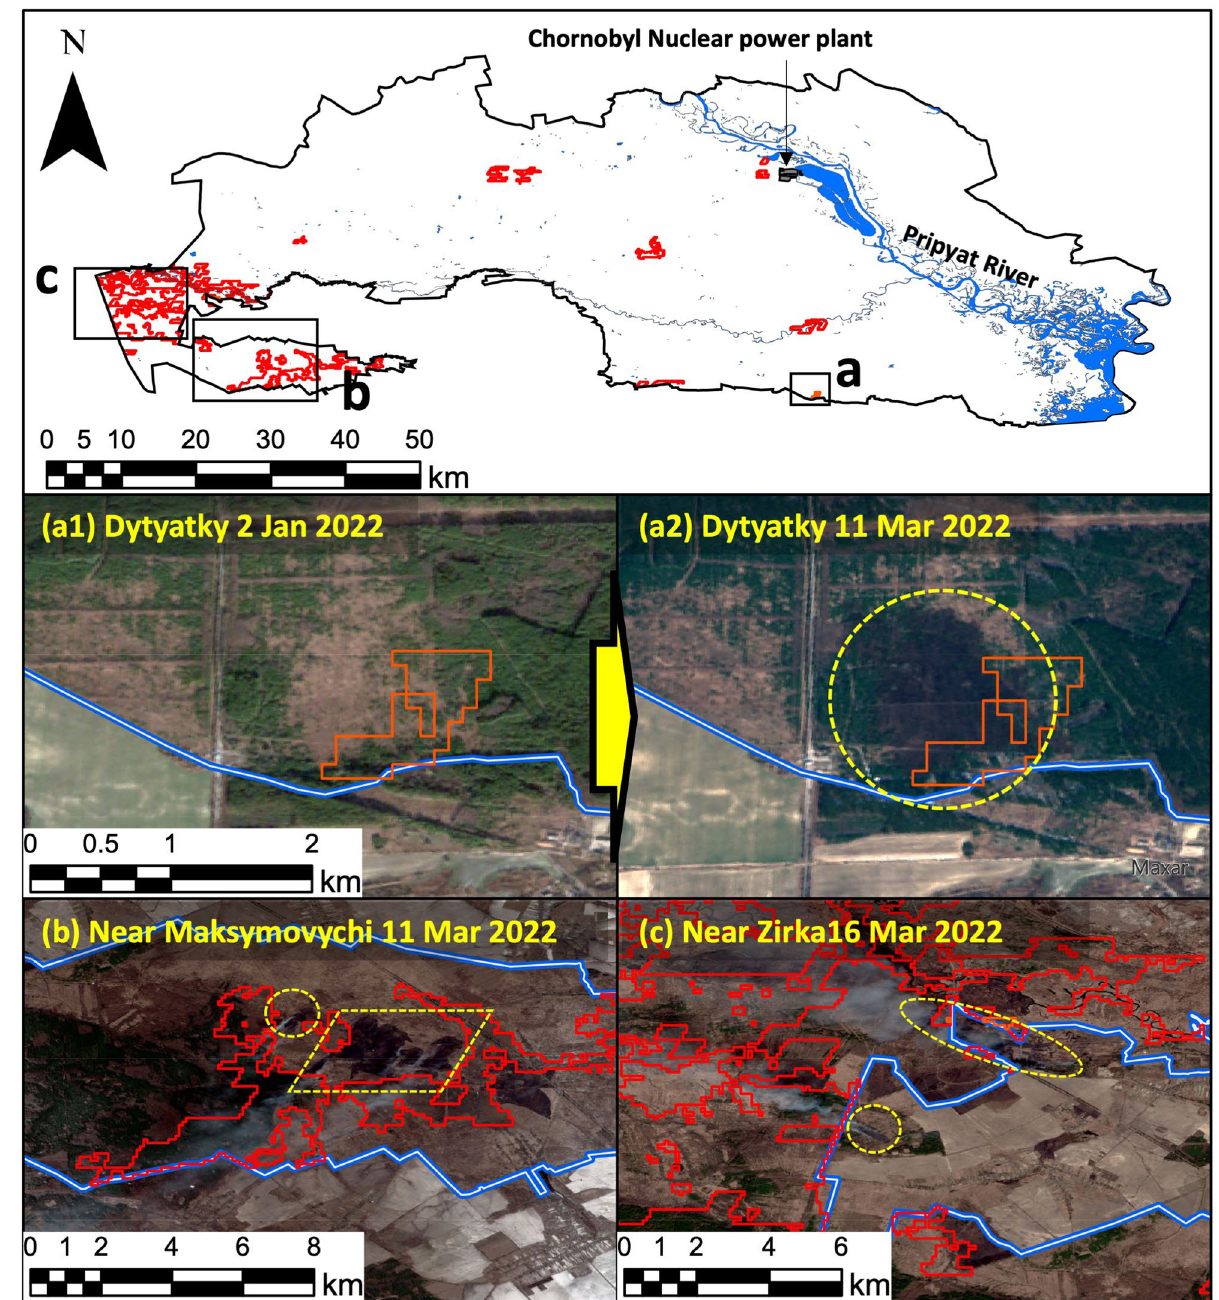
Figure 1. Detected burned area in February and March 2022 at the Chornobyl exclusion zone. Black solid indicates the border of Chornobyl exclusion zone. ( a1 ) and ( a2 ) show changes in the ground surface before and after the fire by Sentinel-2 (yellow dash line) at the place determined to be burned area in February 2022 (orange solid line). ( b ) and ( c ) show the actual wildfire areas and smokes confirmed by Sentinel-2 (yellow dash line) in west part of Chornobyl and where the burned areas were detected in March 2022 (red solid lines). The blue lines in ( a1 ), ( a2 ), ( b ) and ( c ) indicate the border of Chornobyl exclusion grasslands, and farmland in addition to military installations. We considered that TuFda could detect not only burned areas, but also other changes in land surface with a thermal anomaly. Accordingly, we extended the range of our algorithm to cover a wider area extending beyond the ChEZ (Fig. 2), in an effort to ascertain what was happening across northern Ukraine during February and March of 2022. Overall, TuFda detected some land surface changes within a fairly limited area in February (Fig. 2), while in March it detected land surface changes over a wider area.